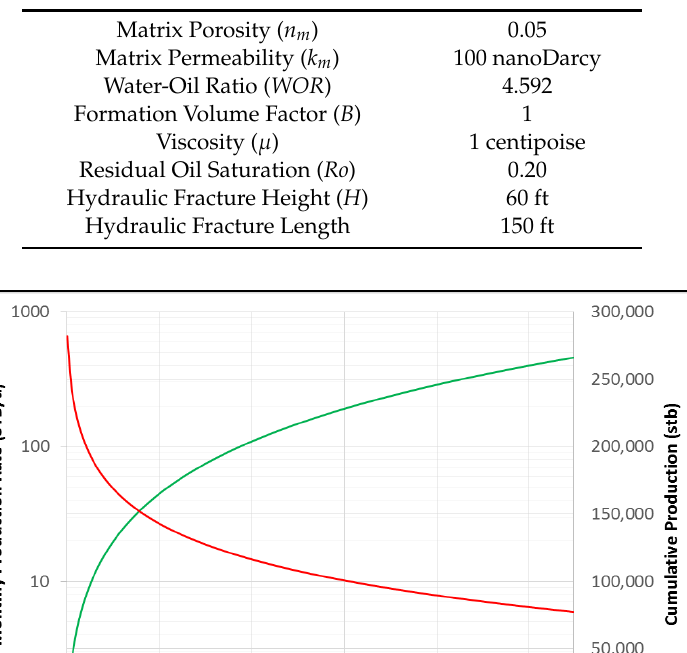
Table A1. Reservoir parameters used for modelling.